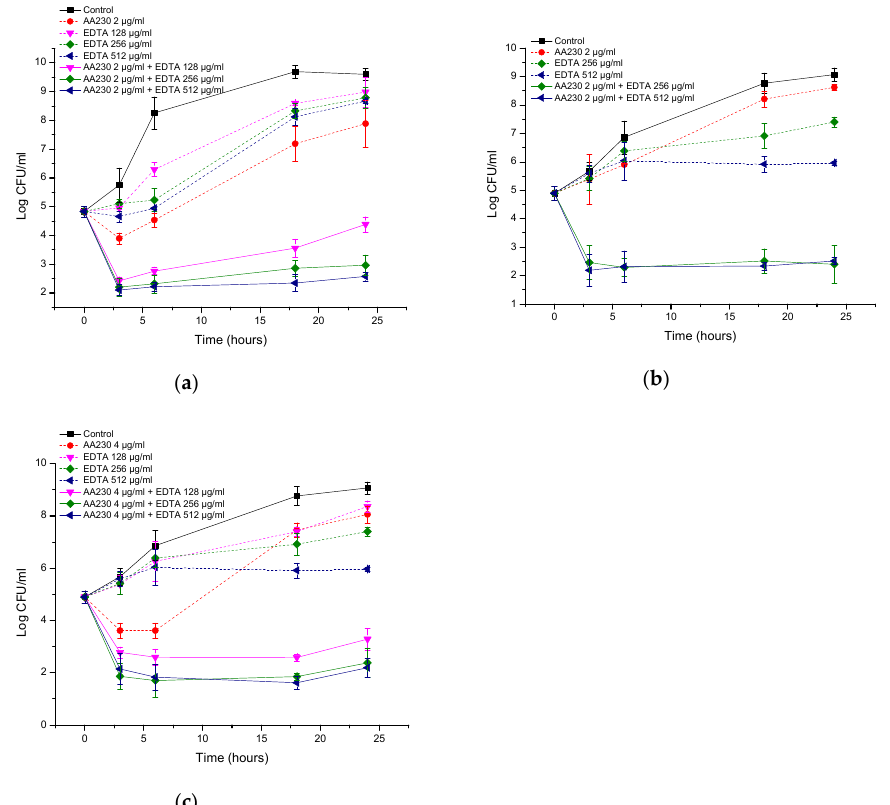
Figure 9. Time-kill curves of antimicrobial peptide AA230 and EDTA used alone and in combination against ( a ) Pseudomonas aeruginosa ATCC;( b , c ) Pseudomonas aeruginosa clinical